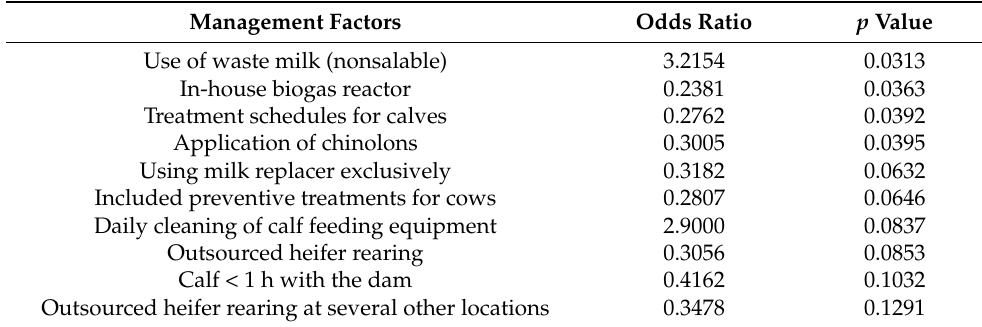
Table 4. Results of the association between the parameters and the level of ESBL/AmpC- E. coli calf prevalence according to the univariable logistic regression